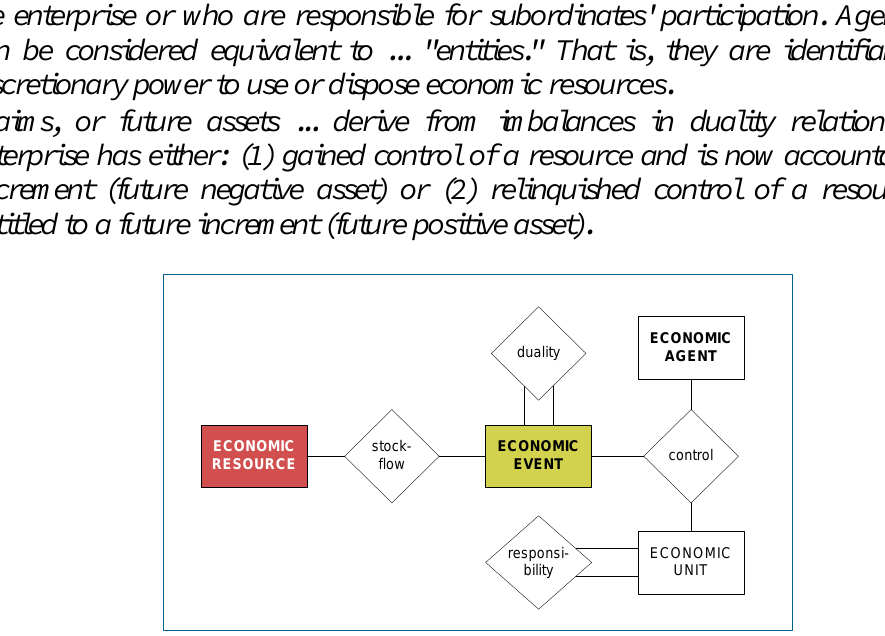
Figure 1. REA Accounting model [1, p. 564] – ER language